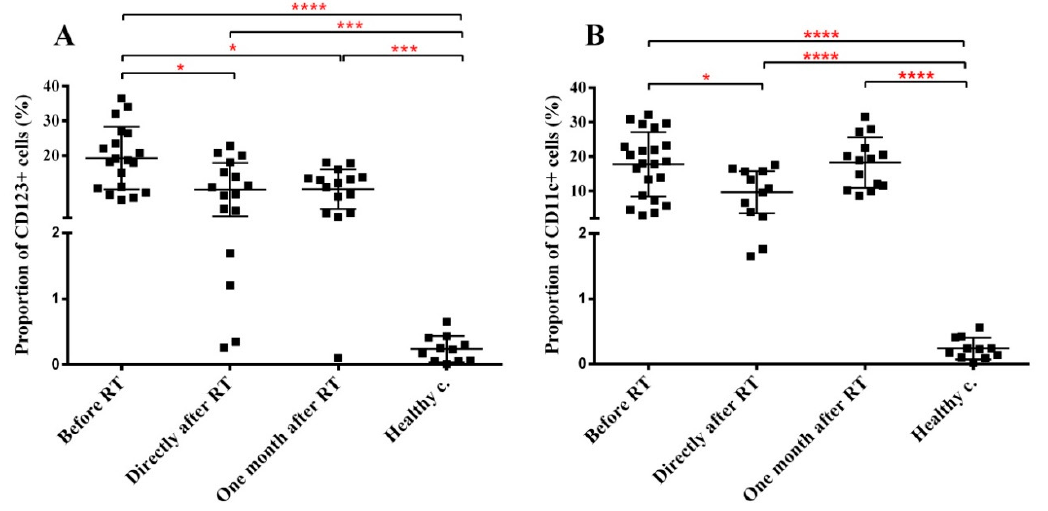
Figure 5. The fraction of circulating dendritic cells increases in the peripheral blood of H&N cancer patients and this increase is maintained after RT, as well. PBMCs were isolated from RT-treated H&N cancer patients, processed and labelled with the corresponding antibodies as described in Materials and methods. ( A ) fraction of CD123 + DCs. ( B ) fraction of CD11c + DCs. Student’s paired t -test was used to test significant di ff erences among the three time points of cancer patients’ samples, while unpaired t -test was used to test significant di ff erences between the three time points and healthy control group using 95% confidence interval. Data are shown as individual data points together with the mean ± SD (cancer patients n = 23, healthy controls n = 15). Significant di ff erences were indicated with * ( p < 0.05), ** ( p < 0.01), *** ( p < 0.001) and **** ( p < 0.0001).